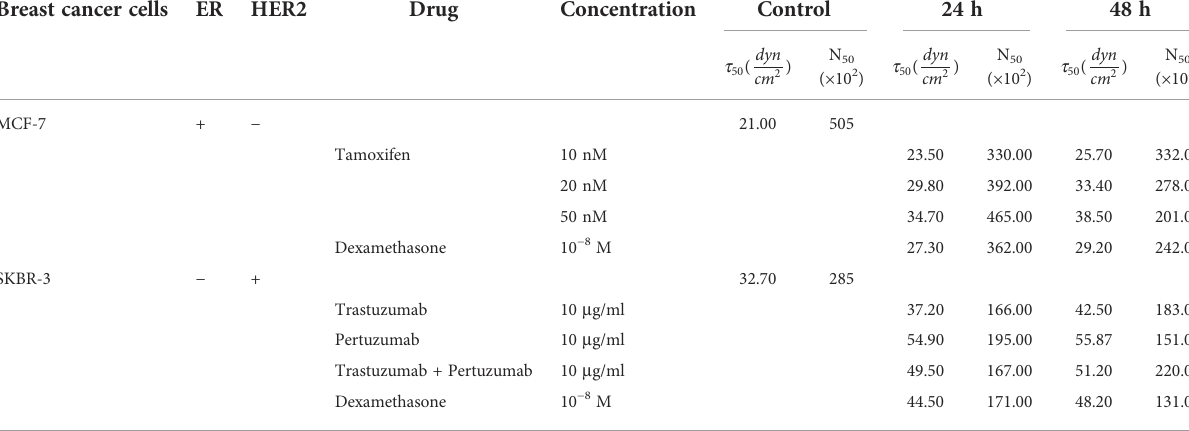
TABLE 2 Cumulative results of MCF-7 and detachment of SKBR-3 breast cancer cells upon treatment. Breast cancer